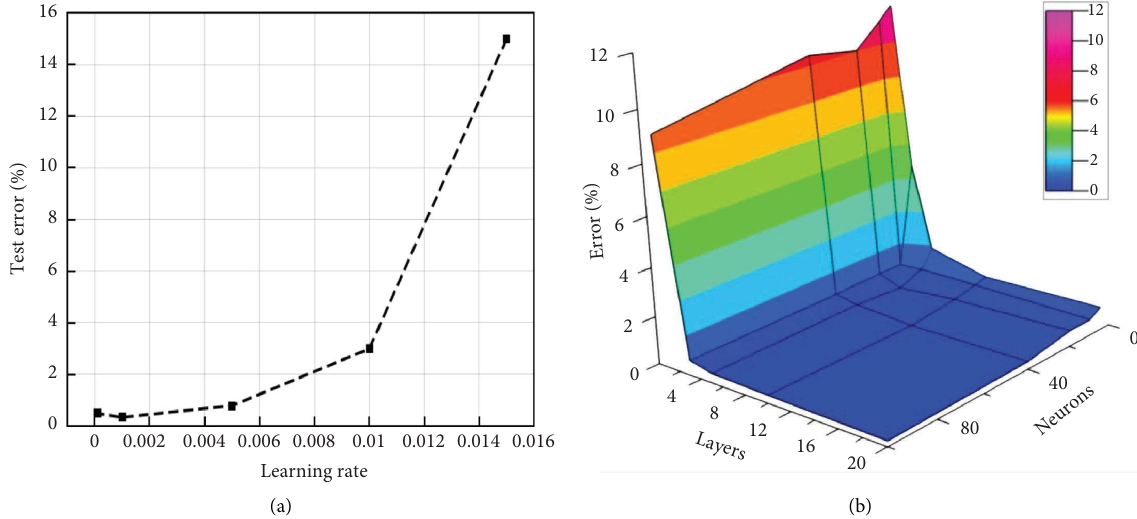
Figure 8: Test errors of PINN-MD under diferent hyperparameters including the initial learning rate (a) and network shape